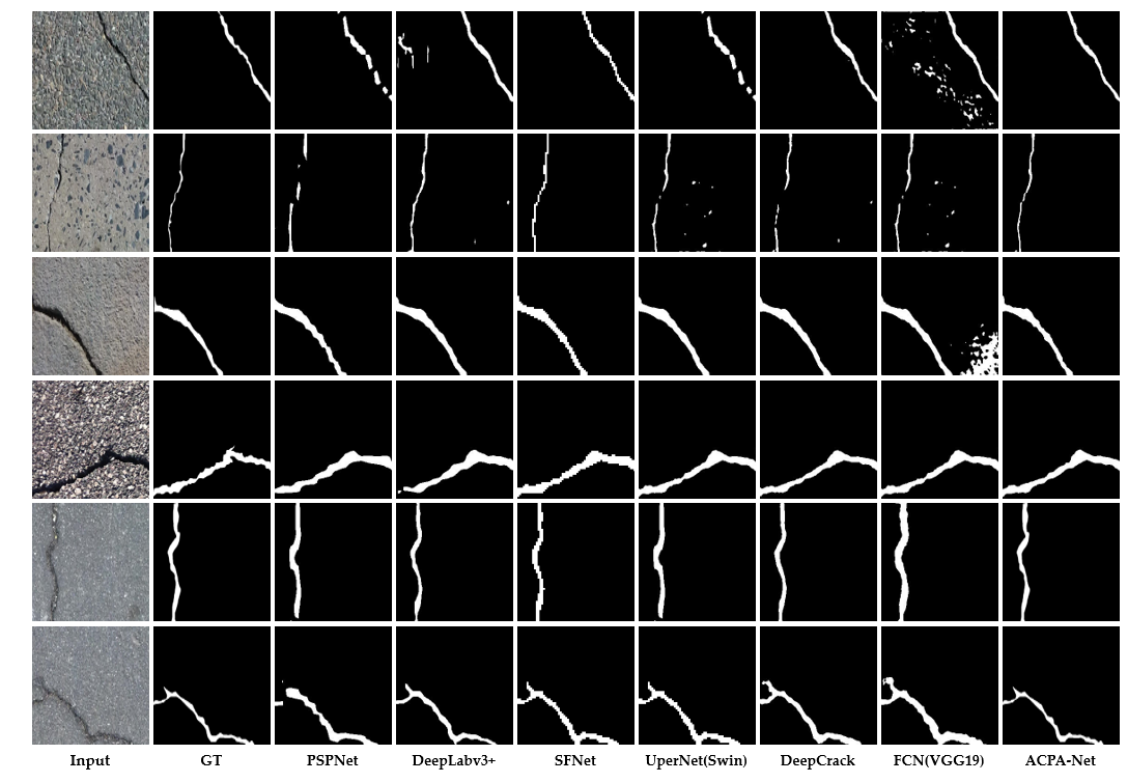
Figure 9. Visualization of the inference results obtained by different state-of-the-art deep learning models on the Crack500 test